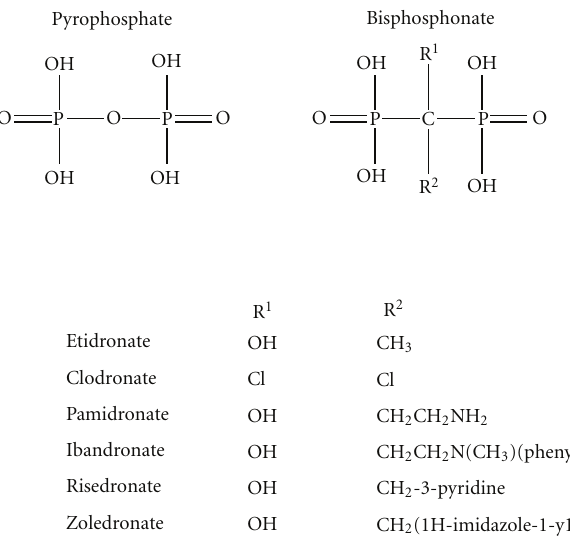
Figure 1: Pyrophosphate and bisphosphonate